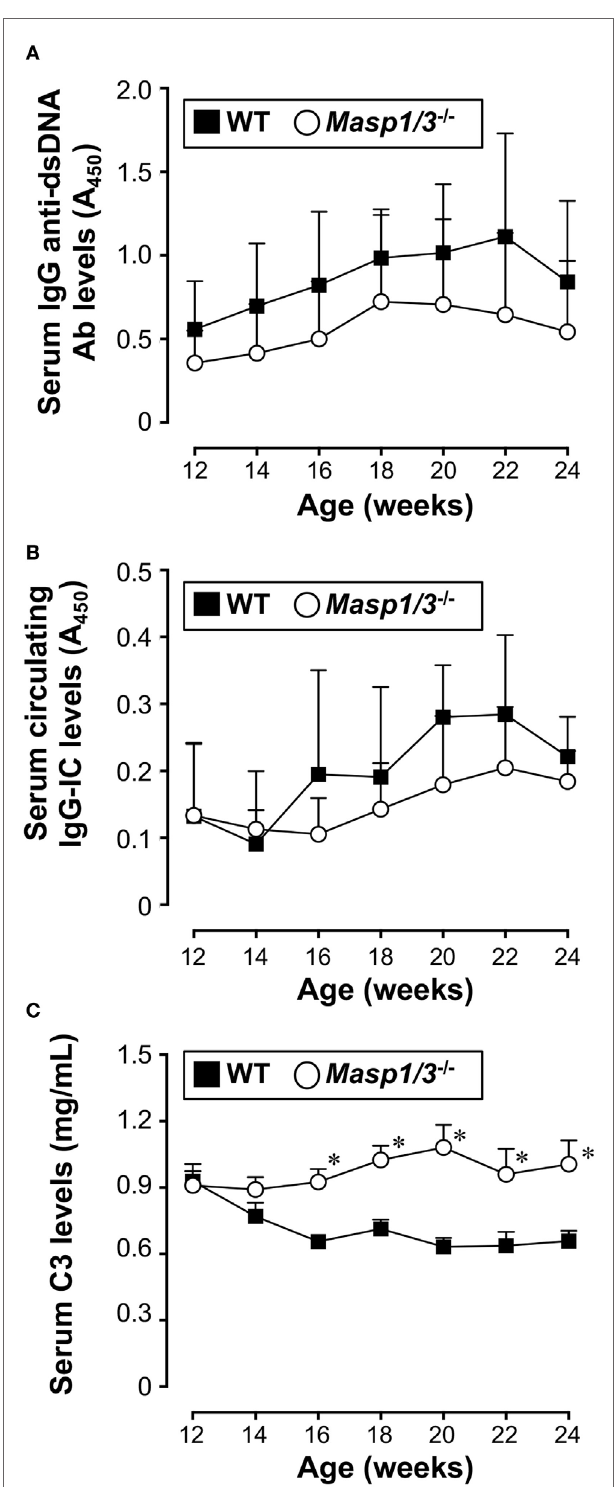
FigUre 3 | Serum levels of IgG anti-dsDNA Ab (a) , circulating IgG-immune complex (IC) (B) , and C3 (c) in 12- to 24-week-old MRL/ lpr mice. Values are means ± SD ( n = 6–8). Values with asterisks are significantly different at * p < 0.05 against values from age-matched WT MRL/ lpr mice.